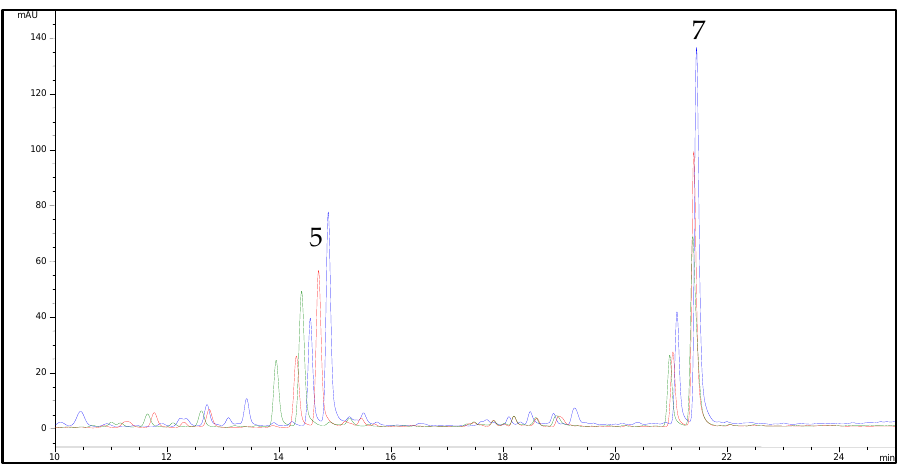
Figure 4. HPLC-UV/DAD chromatograms of a hemp extract (sample C6) in acetone (blue line), EtOAc (red line) and EtOH (green line), recorded at 342 nm. For peak numbering, see Table 1.